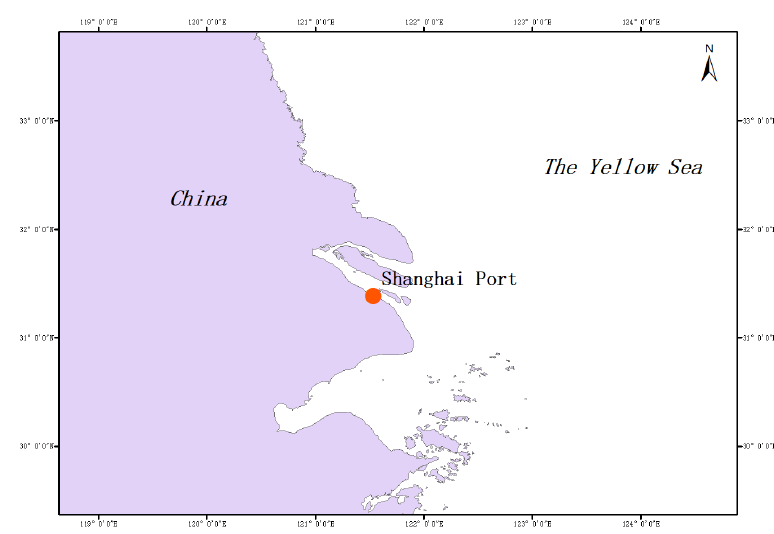
Figure 1. The location of Shanghai Port in China.